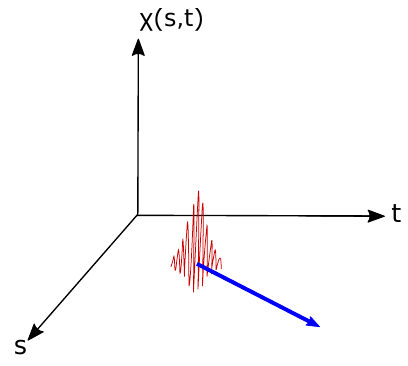
Figure 8 . A wave packet that has a well-de(cid:12)ned collective variables and the conjugate momenta. Under the time evolution, the classical variables evolve obeying the saddle-point